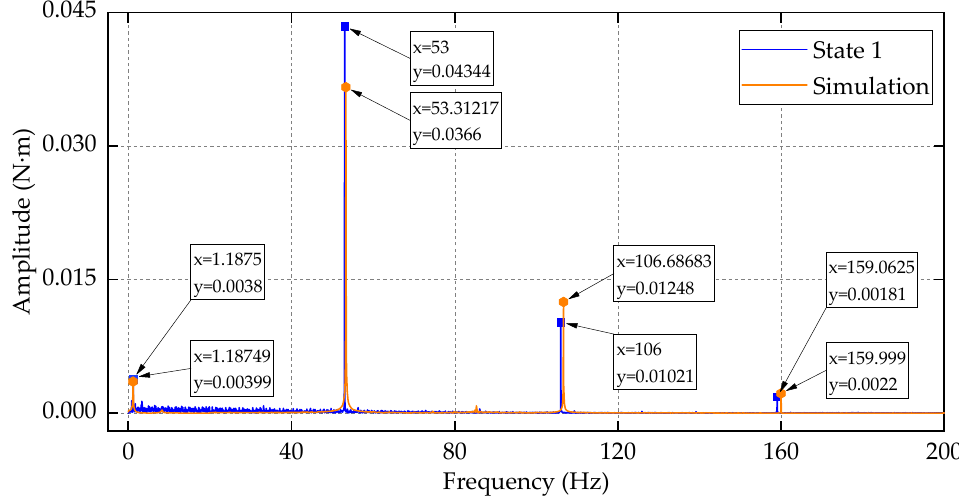
( b ) Moment of inertia test Figure 15. Modal test and moment of inertia test of the SAS. The tested moment of inertia of the SAS about the rotation axis, which is 8.19 kg·m 2 , was taken as reference; the error of the moment of inertia calculated by the finite element model was 0.27 kg·m 2 , and the relative error was only 3.3%. Table 4 shows the frequencies of the first three modes obtained by finite element method and test. The table shows that the frequency error is no more than 3.15%, which indicates that the finite element model is an accurate model of the SAS under test state 1. Table 4. Comparison of modal frequency . No.